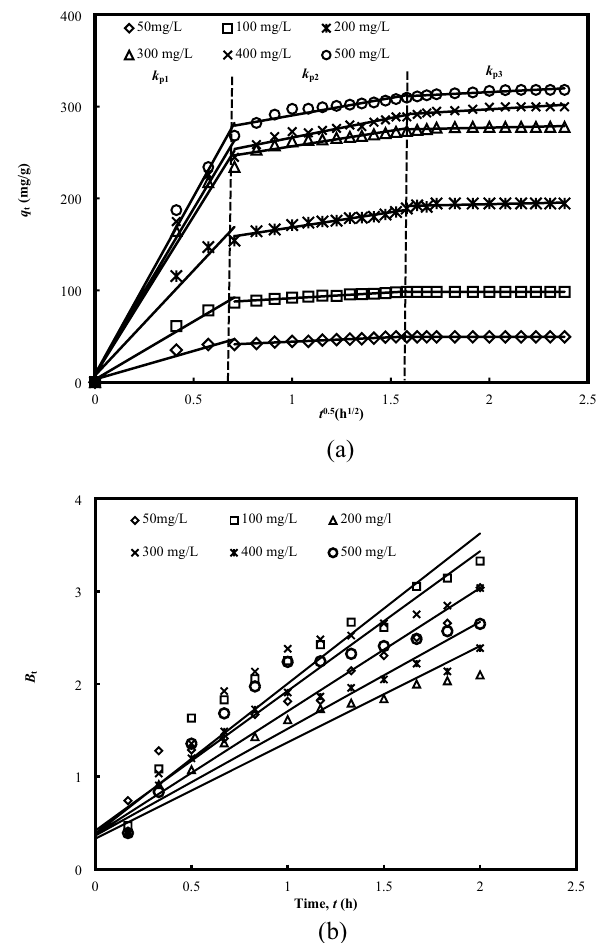
Figure 4. Intraparticle diffusion ( a ) and Boyd plots models ( b ) for the adsorption of MB onto BB at 30